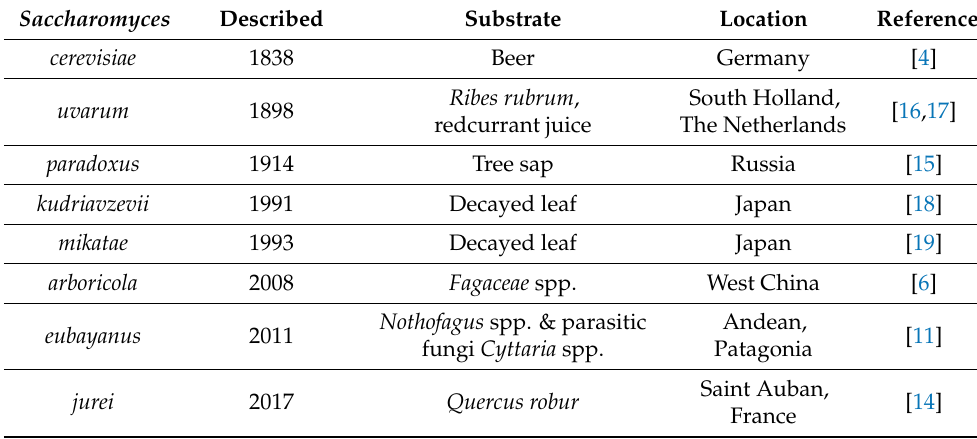
Table 1. Current Saccharomyces Yeast Species History. Saccharomyces Described Substrate Location Reference cerevisiae 1838